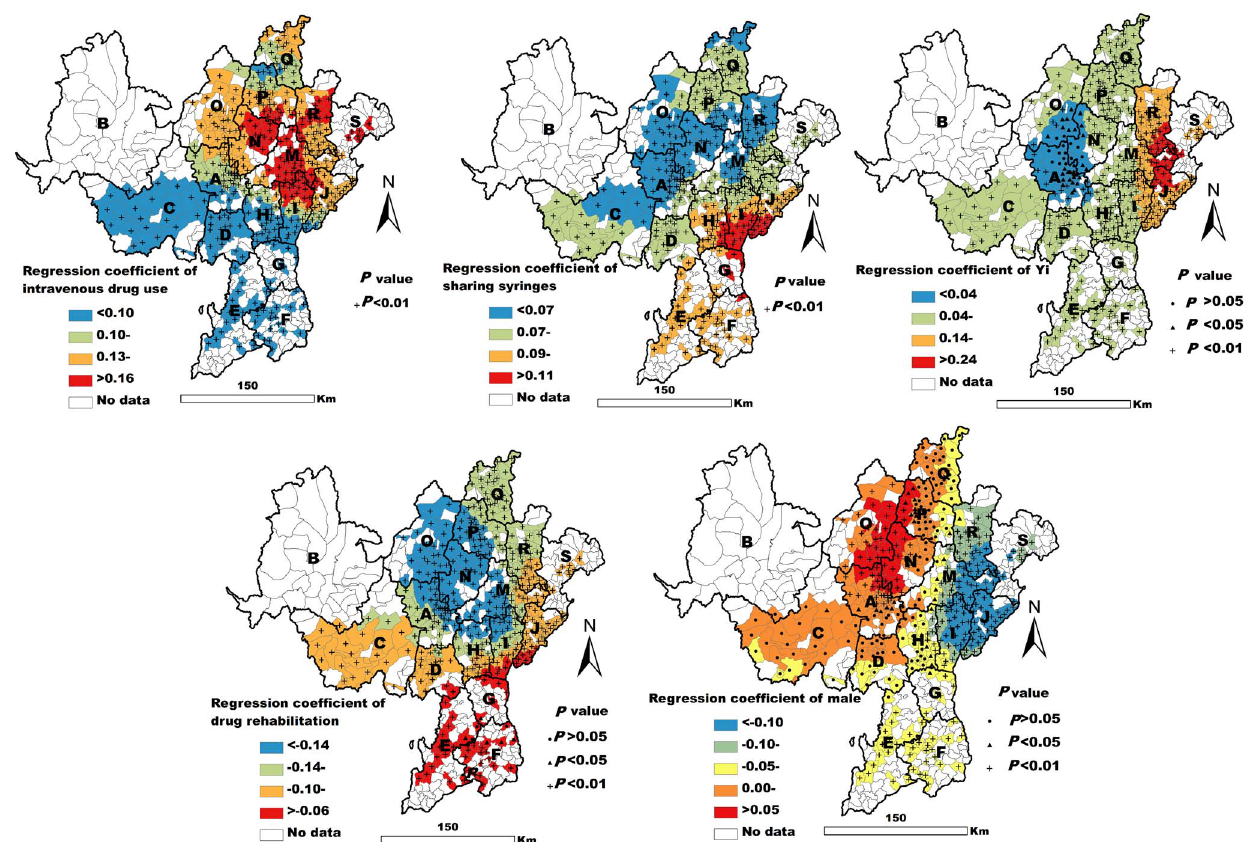
Figure 2. Spatial map of the GWR coefficients of five variables associated with HIV infection.